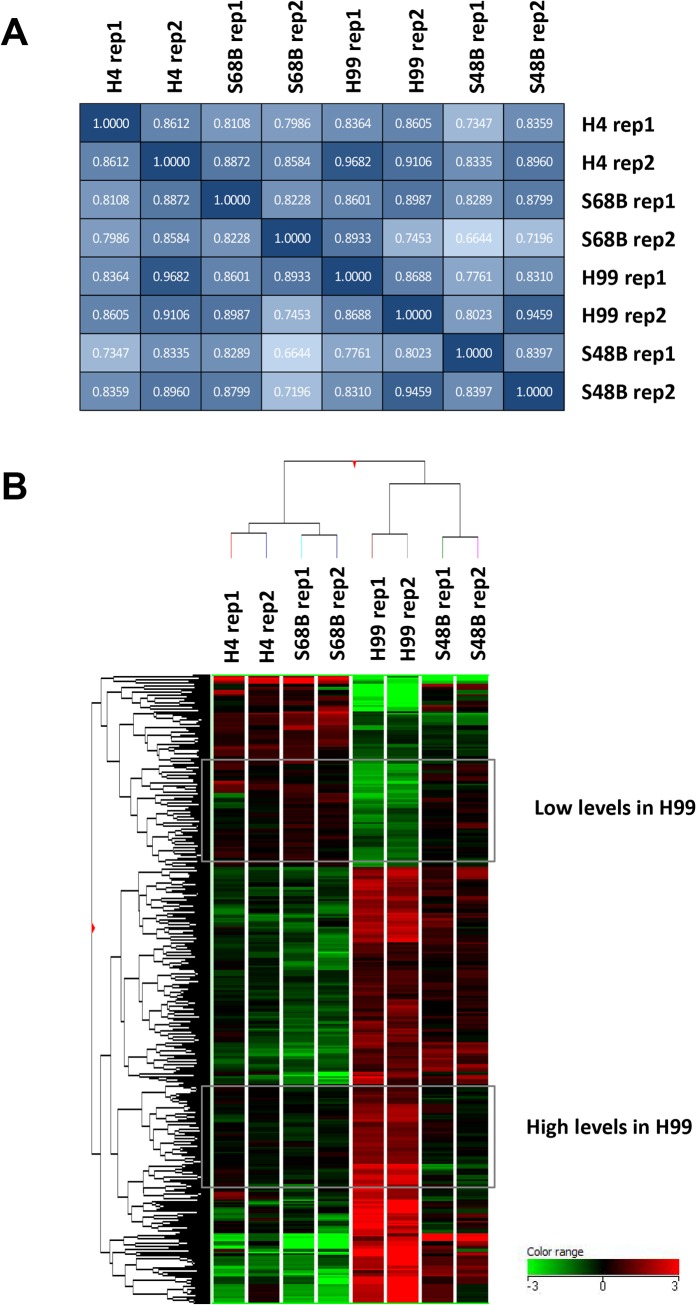
Microarray analysis.(A) Pairwise correlation matrix. Four C. neoformans strains (H99, H4, S48B and S68B) were compared. Two independent samples were prepared for each fungal strain. Rep1–2: replicates of samples. Numbers in the box represents correlation coefficient values among groups. Dark box: high correlation; light box: low correlation. (B) Gene expression heat map. Dendrogram represents the colour-coded expression levels of the significantly regulated genes. The groups of genes which showed differential expressions in H99 versus other strains were as indicated. Low levels in H99 category indicates the genes with low expression levels in H99 (green) but high expression in the environmental strains (red). In contrast, high levels in H99 category indicates the genes with high expression levels in H99 (red) but show low expression in the environmental strains (green). Hierachrical cluster was performed with Euclidean distance metric and Ward’s Linkage rule clustering. Colour range represents log10 (FC) of the microarray intensities.